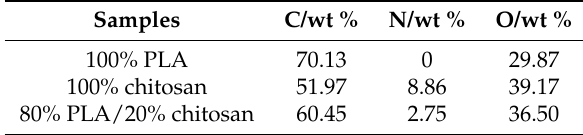
Figure 5. EDX element analysis: ( a ) PLA fibres and ( b ) PLA/chitosan fibres; ( c ) SEM image of PLA/chitosan membrane, EDX mapping of electrospun PLA/chitosan membrane: ( d ) C, ( e ) N and ( f ) O elements on the surface of the fibres. Table 4. EDX analysis of the element contents in the materials.